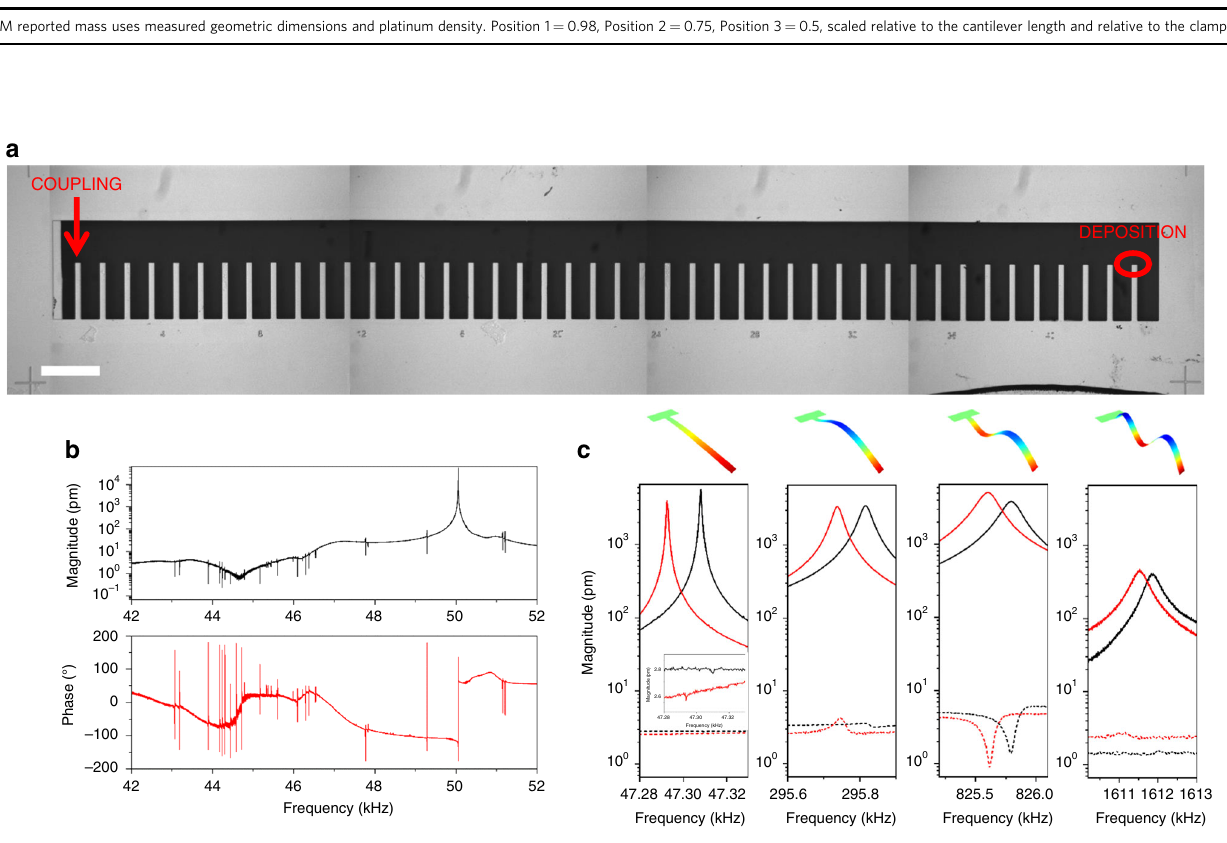
Fig. 5 Weak-coupling peak analysis on a large 44-resonator array. a SEM image of the resonator array composed by 44 nominally identical cantilevers. Platinum mass is deposited on the right-most resonator, while the weak-coupling peaks are measured on the left-most resonator. The scale bar is 500 µ m. b Amplitude and phase of the vibration spectrum of the left-most cantilever of the array showing the asymmetric weak-coupling peaks which are related to all other 43 resonators. c Comparison of the primary Lorentzian and weak-coupling peaks for the fi rst four CECs. Solid curves are the resonator responses with the deposited mass placed in the right-most position, while the dotted curves are the response of the resonator in the left-most position of the